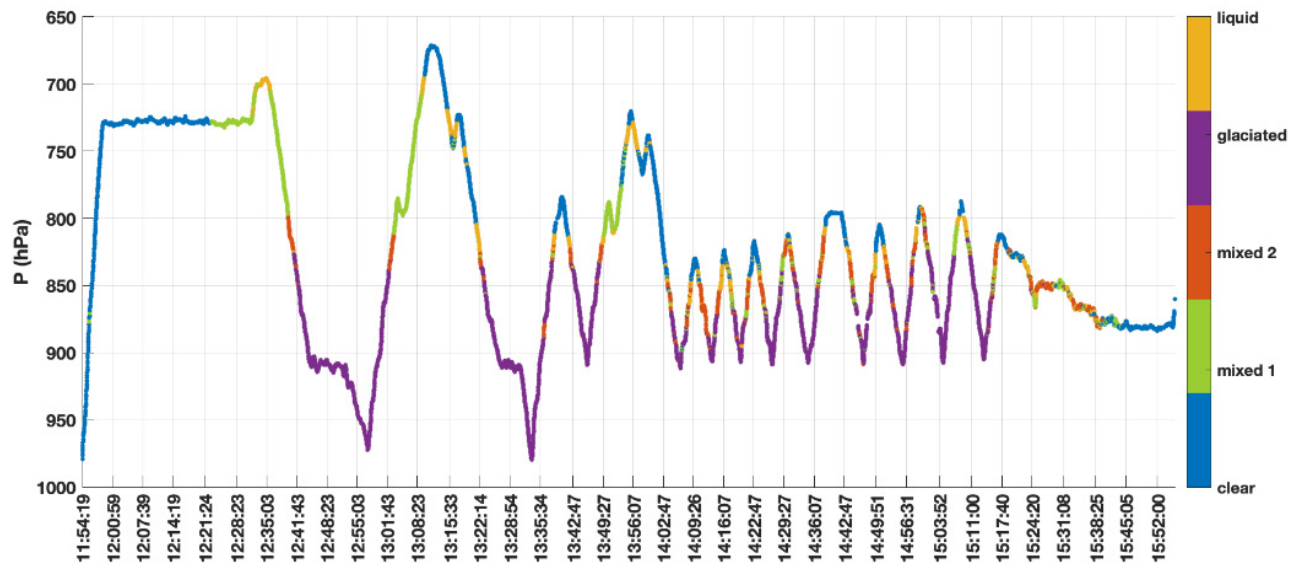
Figure 12. Time series of aircraft pressure-altitude flight profile on 5 March 2019 (F28).